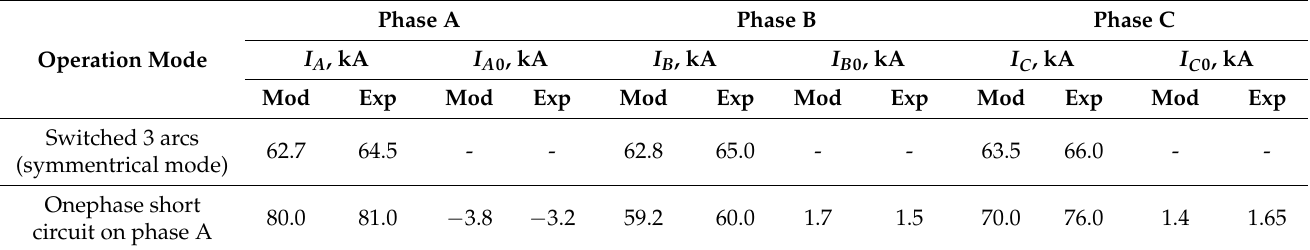
Table 1. Comparison of the calculation results of arc currents with the results of the experiment: I A